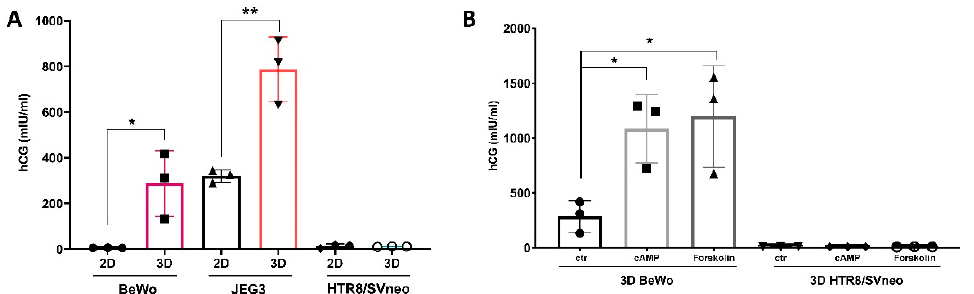
Figure 5. Human chorionic gonadotropin production in trophoblast spheroids. Comparison of hCG production in 2D vs. 3D trophoblast cell cultures ( A ) and after cAMP and forskolin stimulation ( B ). * p < 0.05; ** p < 0.01.